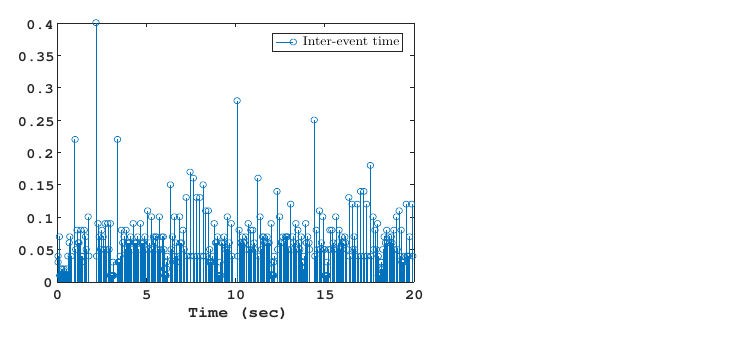
Figure 8. The horizontal axis and vertical axis represent the trigger times and trigger intervals,